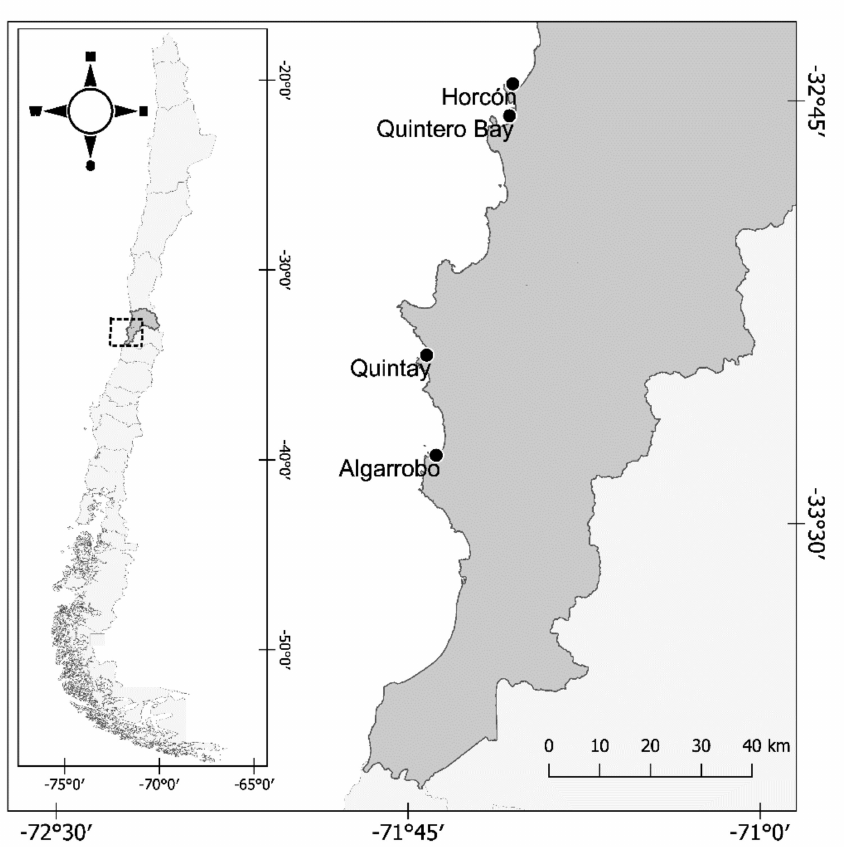
Figure 1. Map of the researched areas in this study. The gray area represents the Valpara í so region of